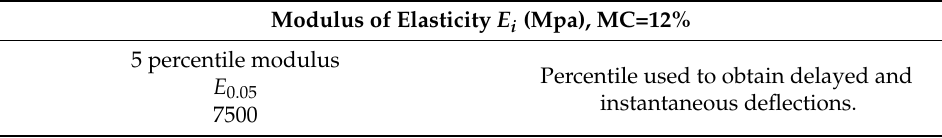
Table 2. Modulus of Elasticity for Guadua